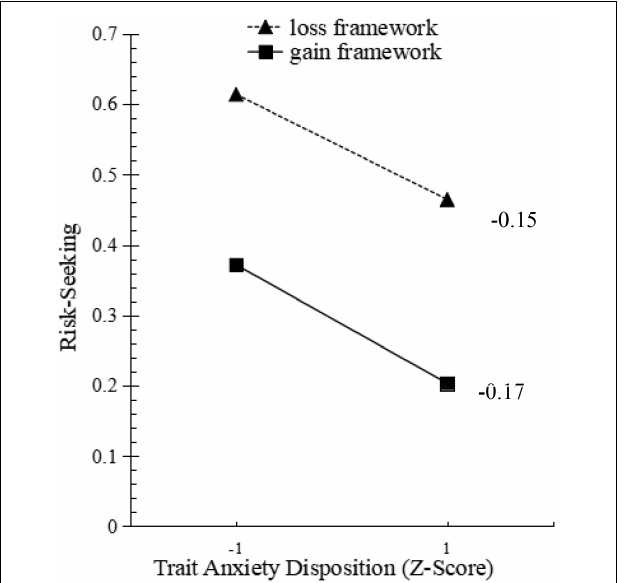
FIGURE 1 | The effects of trait anxiety and framing effects on